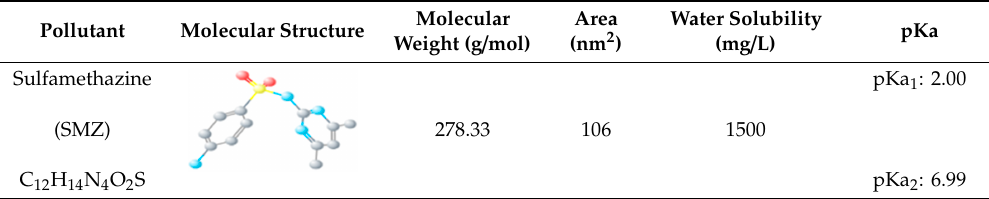
Table 5. Properties of SMZ.